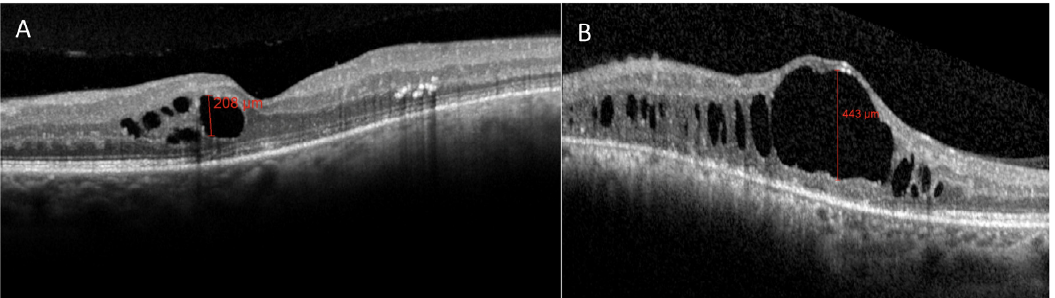
Figure 14. OCT imaging of patients affected by radiation maculopathy at different disease stages. ( A ) A patient affected by a relatively early-stage radiation maculopathy characterized by evident cystoid macular edema, having the vertical thickness of the largest macular cyst of 208 µm, and by the absence of the IS/OS layer disruption and RPE central atrophy (C208, J0, A0). ( B ) A patient characterized by an advanced stage radiation maculopathy characterized by evident cystoid macular edema having the vertical thickness of the largest macular cyst of 443 µm and by the presence of both the IS/OS layer disruption and RPE atrophy (C443, J1, A1).